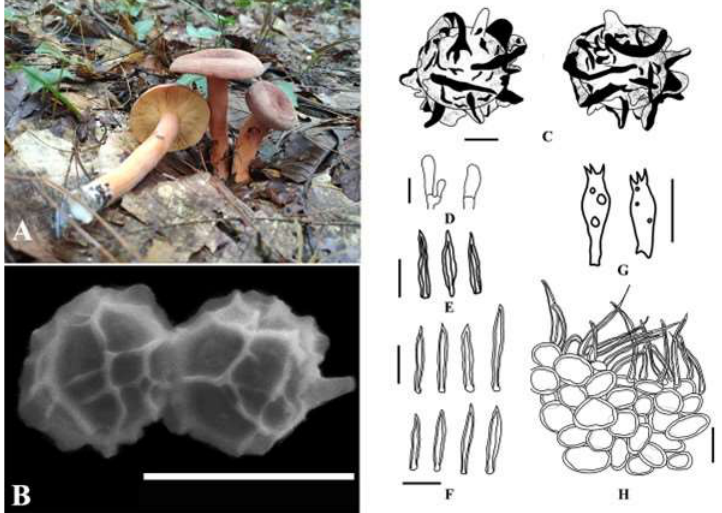
Figure 2. The MycoBank ID is 842968. The etymology refers to the collection site “Taibai”, and the holotype is HKAS 122860.